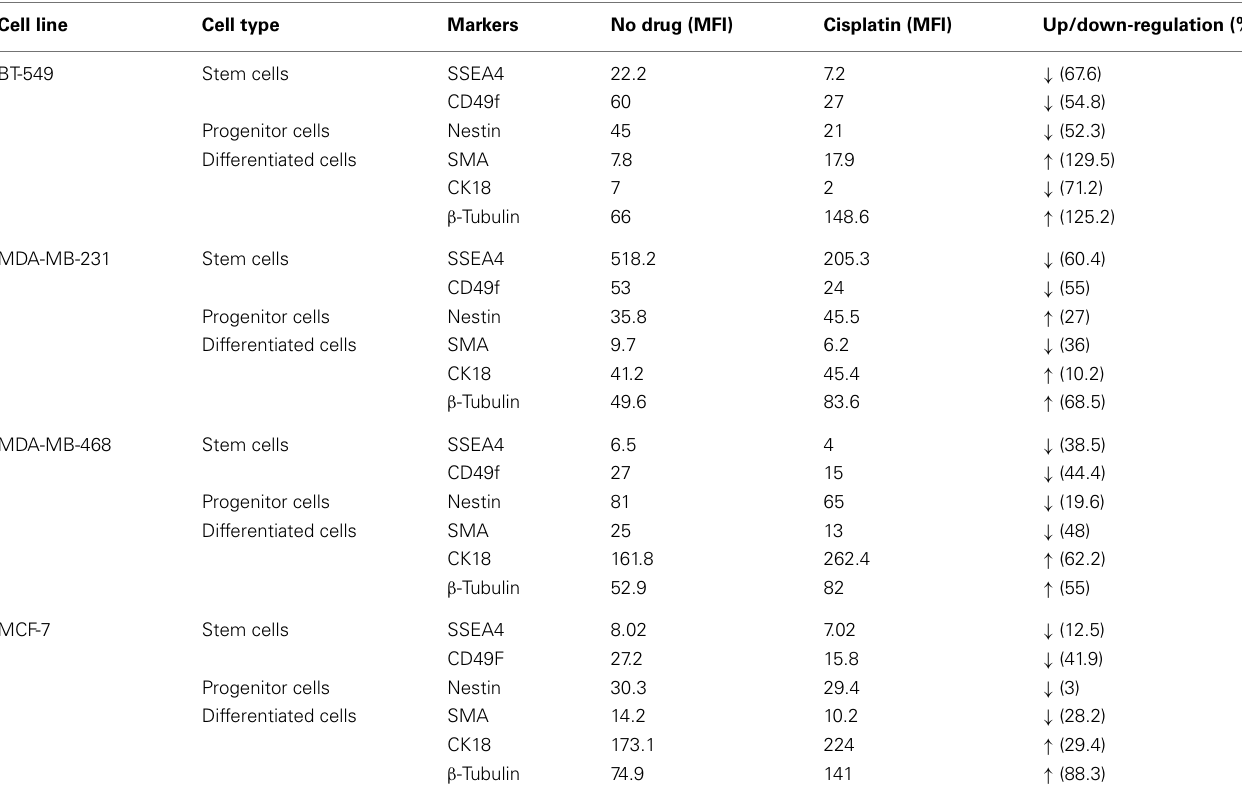
MFI, mean fluorescence intensity; ESC, embryonic stem cell; SSEA4, stage specific embryonic antigen-4; CD49f, integrin subunit- α 6; SMA, smooth muscle